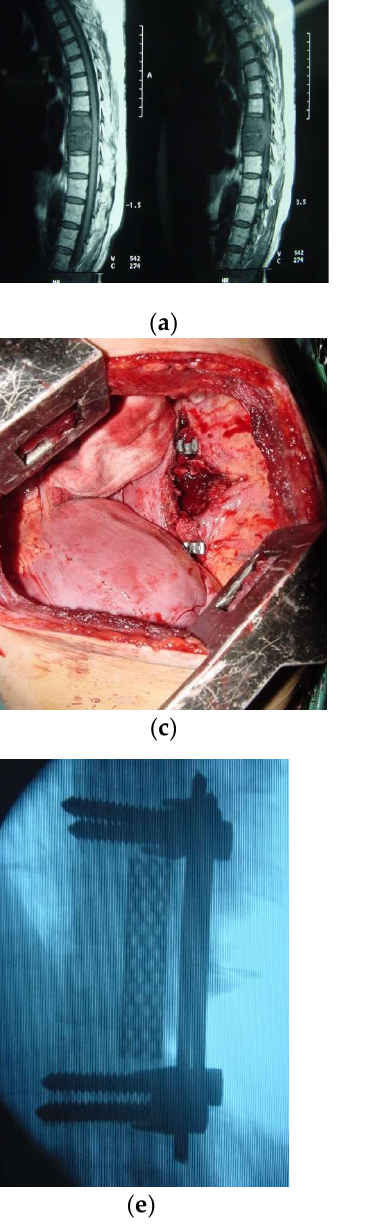
Figure 1. ( a ) Shows a MID-thoracic tuberculous lesion on MRI; ( b ) cylindrical mesh cage with in- fused bone graft; ( c ) shows an intraoperative picture with a prepared site for cage placement; ( d ) shows the anterior fixation with rods and a mesh cage; ( e , f ) shows post-operative radiological images of anterior transthoracic surgery and fusion with a mesh cage.